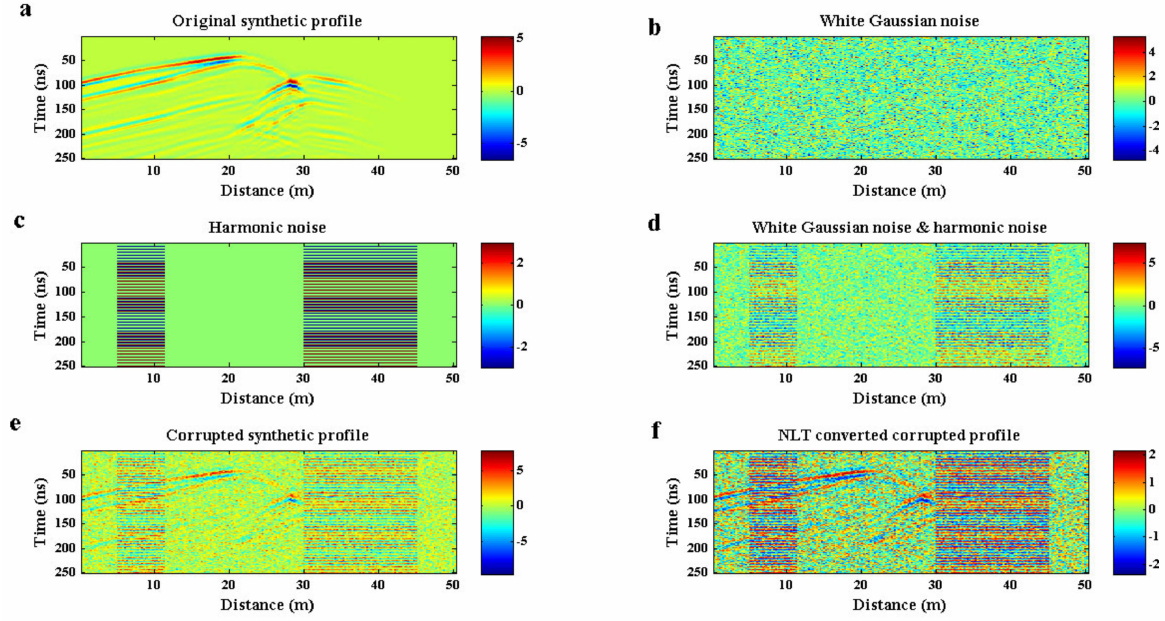
Figure 7. Realistic model synthetic profile, interfering noises, and noise-corrupted profiles. ( a ) GPR reflection profile of the proposed model. ( b ) White Gaussian noise. ( c ) Harmonic noise. ( d ) Combination of the white Gaussian noise and harmonic noise. ( e ) GPR reflection profile corrupted by the white Gaussian noise and harmonic noise. ( f ) NLT conversion of the noise-corrupted reflection